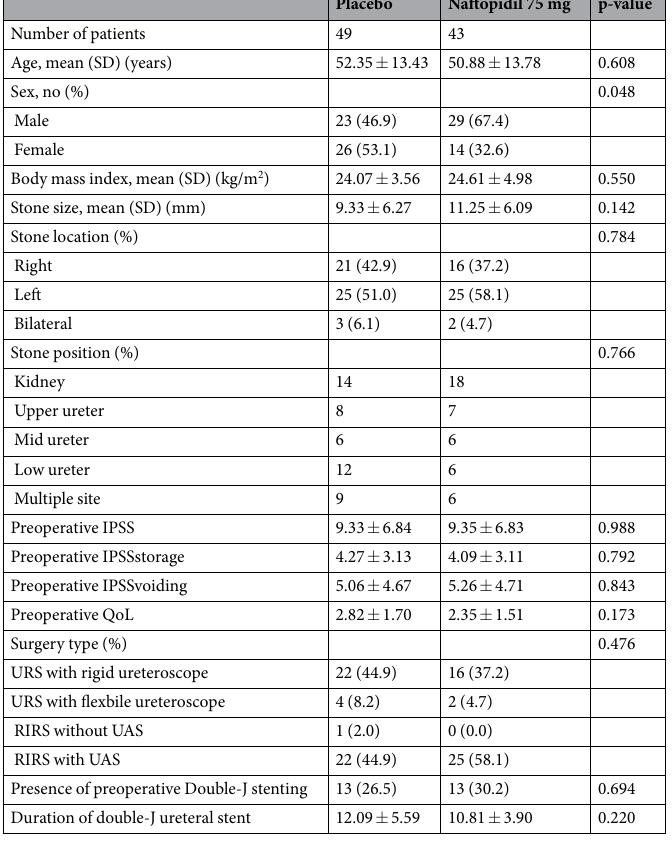
Table 1. Baseline characteristics. SD, standard deviation; IPSS, international prostate symptom score; URS, ureteroscopy; RIRS, retrograde intrarenal surgery; UAS, ureteral access